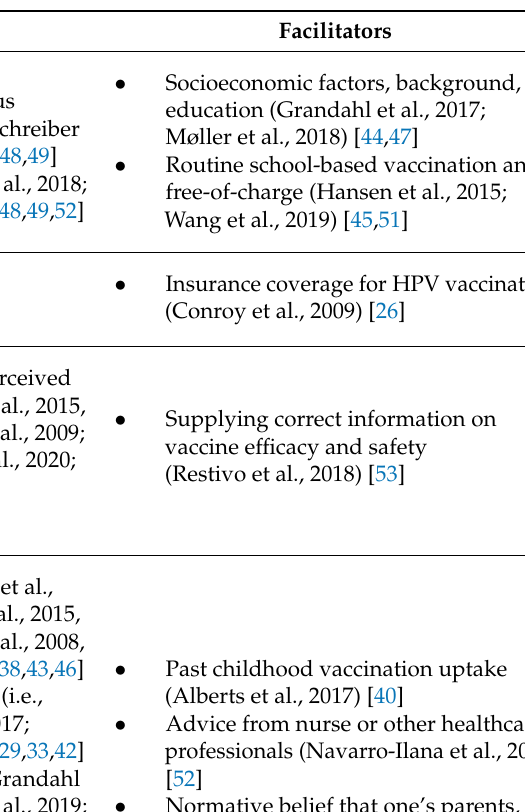
Table 2. Barriers and facilitators of vaccination